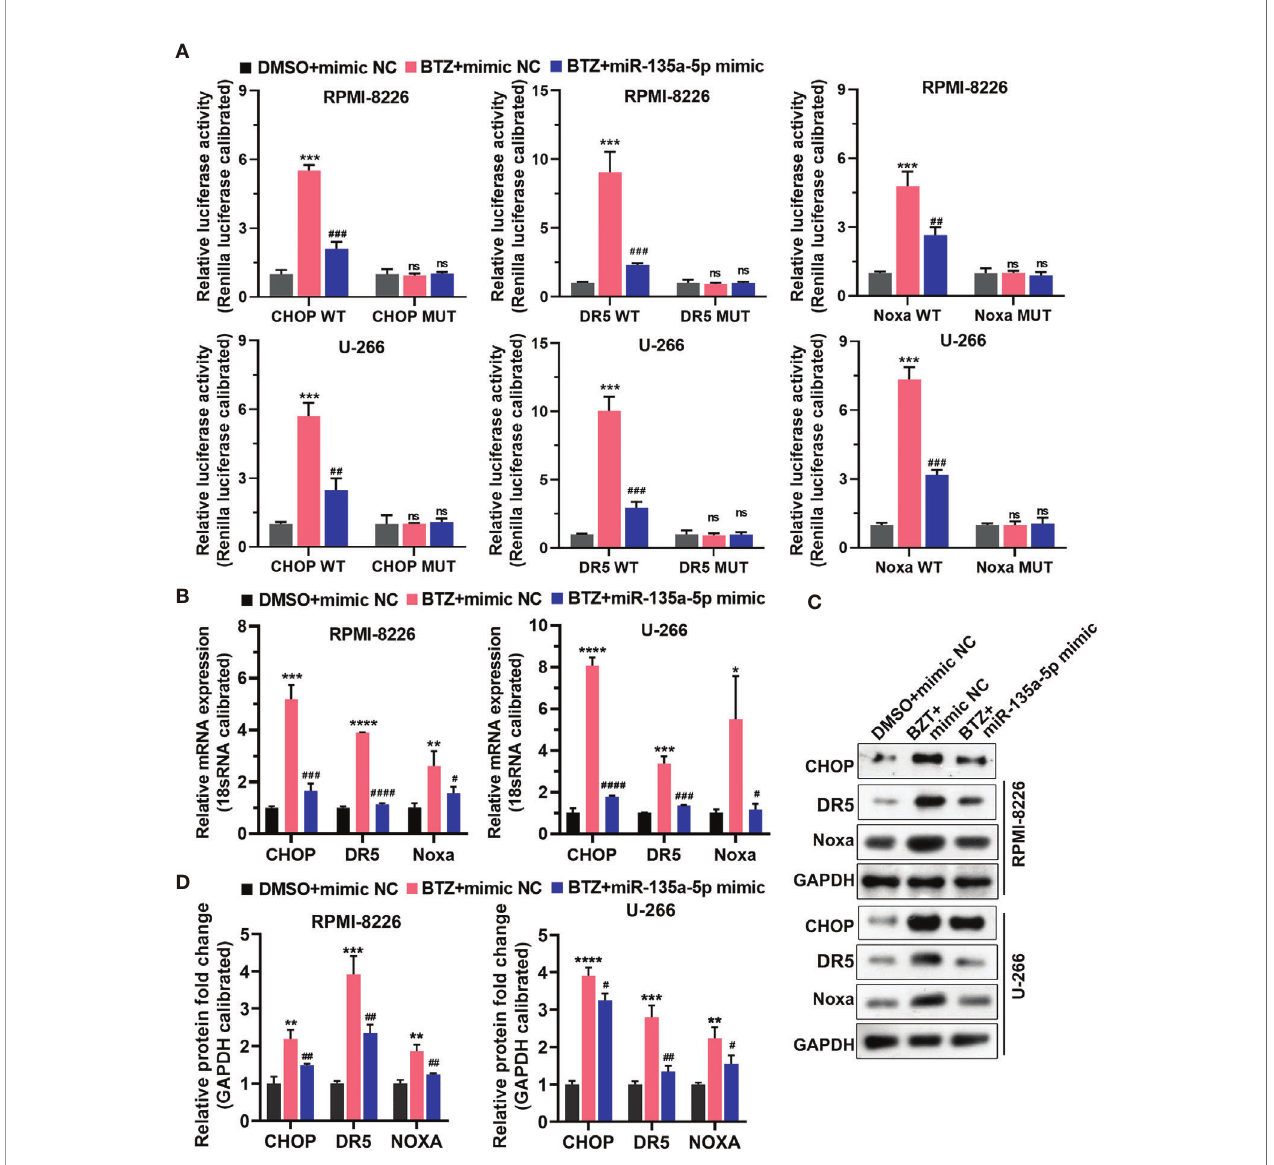
FIGURE 5 | Expression of CHOP, DR5, and Noxa mRNA was analyzed in three groups: (A) DMSO + mimics NC; (B) BTZ + mimics NC; (C) BTZ + miR-135a-5p mimics. (A) The relative luciferase activity of CHOP, DR5, and Noxa was detected in RPMI-8226 and U-266 cells of the three groups. (B) CHOP, DR5, and Noxa mRNA levels were analyzed by RT-qPCR in the three groups. (C) CHOP, DR5 and Noxa protein levels were measured by western blotting in the three groups. (D) Quanti fi cation of CHOP, DR5, and Noxa band intensity, with values normalized to GAPDH. One-way ANOVA followed by Tukey ’ s post-hoc test was used for statistical analysis. Ns, no signi fi cance; *P < 0.05, **P < 0.01, ***P < 0.001, and ****P < 0.0001 compared with the BTZ + mimic NC group; # P < 0.05, ## P < 0.01, ### P < 0.001, and #### P < 0.0001 compared with BTZ + miR-135a-5p mimic